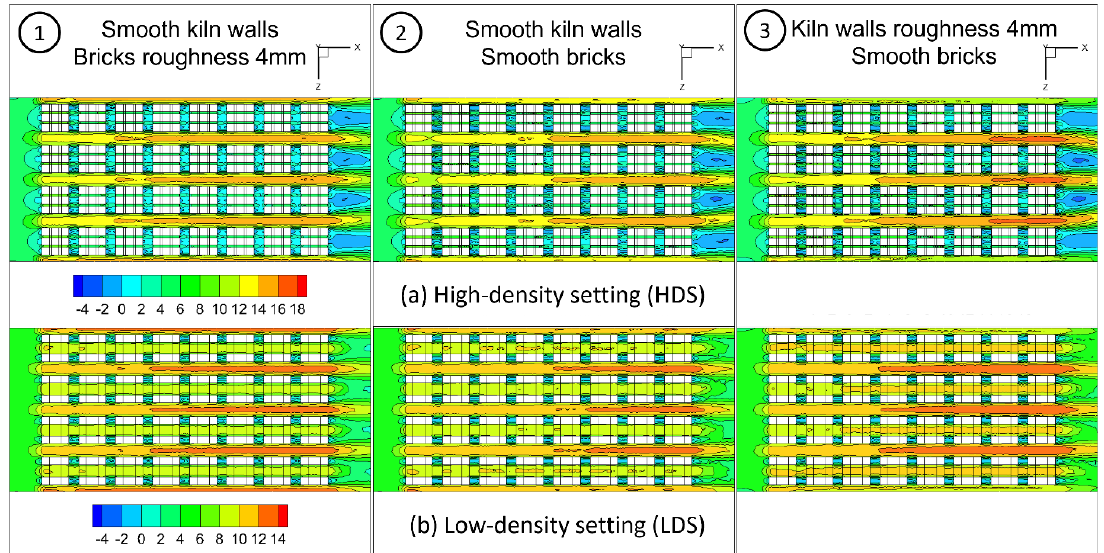
Figure 4. Comparison of the velocity contours in the ( a ) high-density setting and ( b ) low-density setting for (1) smooth kiln walls and rough bricks, (2) smooth kiln walls and bricks, and (3) rough kiln walls and smooth bricks.